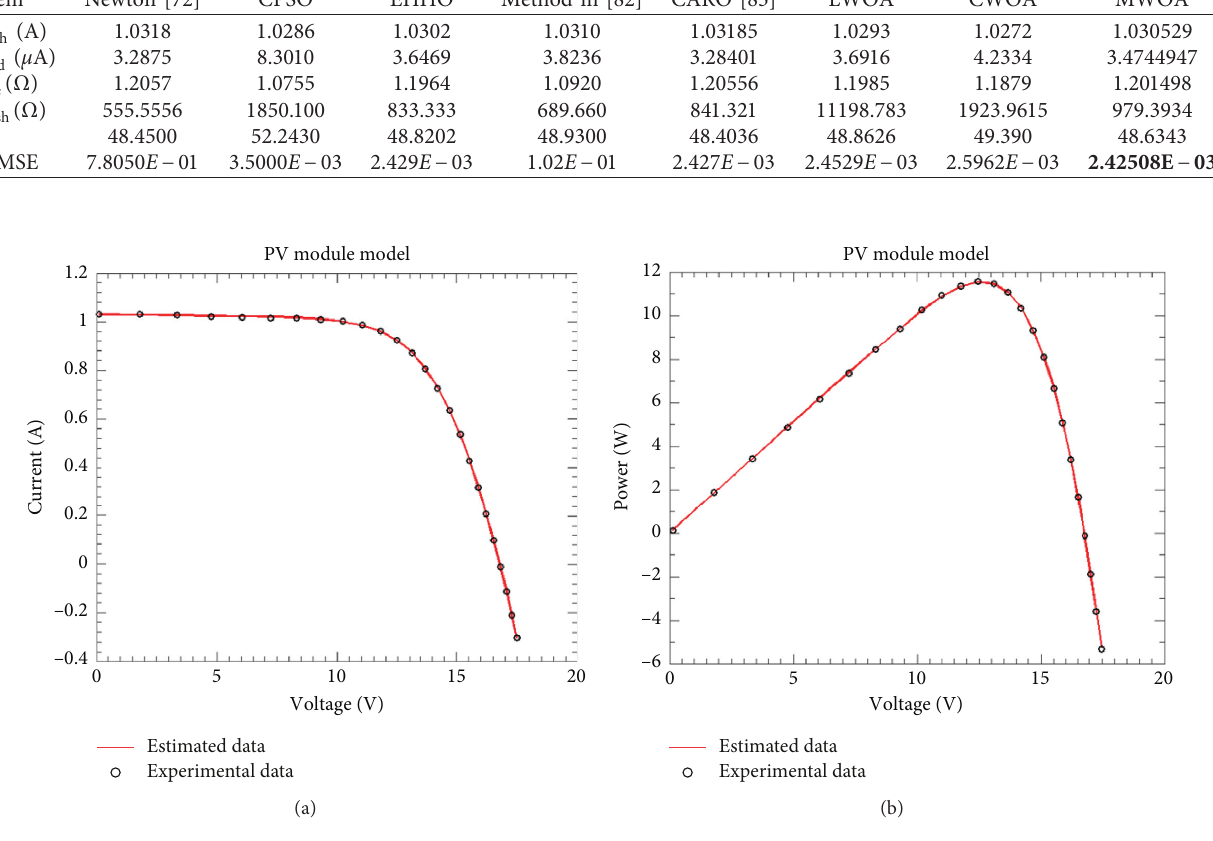
Figure 9: I-VC (a) and P-VC (b) of the best PV module model obtained based on MWOA.